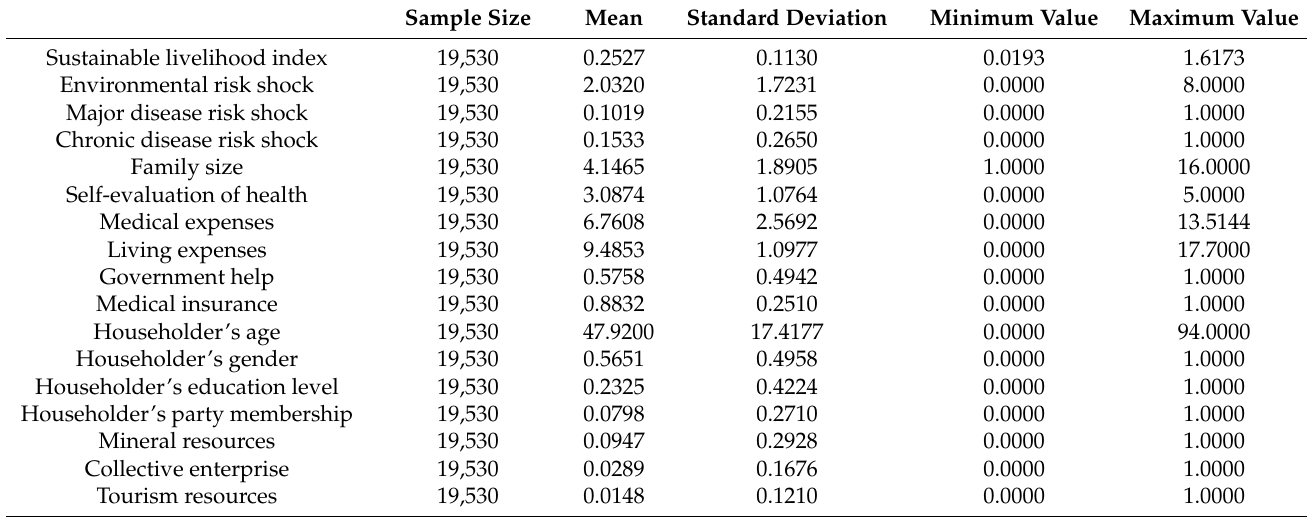
Table 3. Descriptive statistical characteristics of the